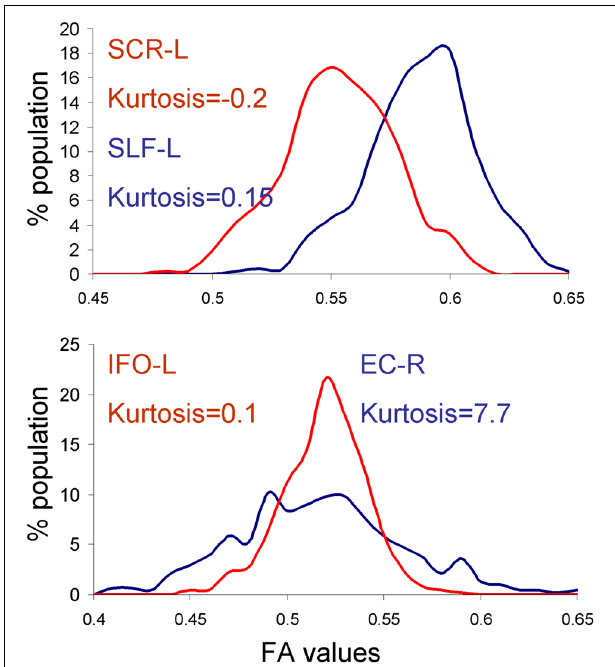
FIGURE 4 | Histograms for the dataset that showed reduced heritability estimates for fast vs. MLE based heritability estimation approaches. APACE showed reduced heritability estimates in superior corona-radiata-right (SCR-L) and SLF-L tracts in the human connectome project (HCP) cohort due to deviations from normal distribution (top panel). FPHI showed reduced heritability estimates in the external capsule-right (EC-R) and inferior fronto-occipital tract-left (IFO-L) tracts in the HCP cohort due to the high kurtosis and non-Gaussian shape of the histograms for EC-R and IFO-L,